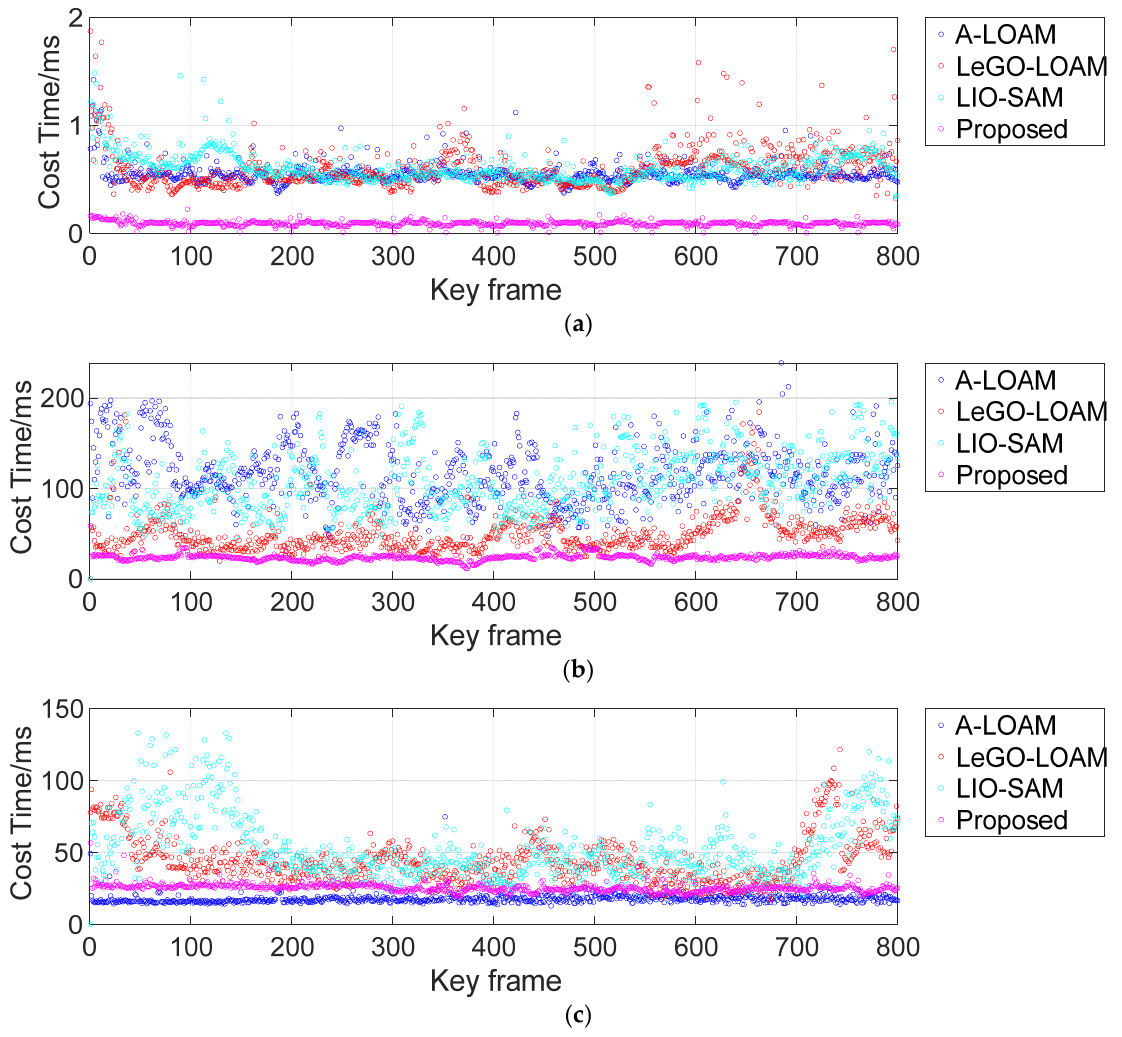
Figure 14. Time-consuming comparison of three processes. ( a ) Point cloud downsampling process. ( b ) Point cloud registration process. ( c ) Position global optimization process.